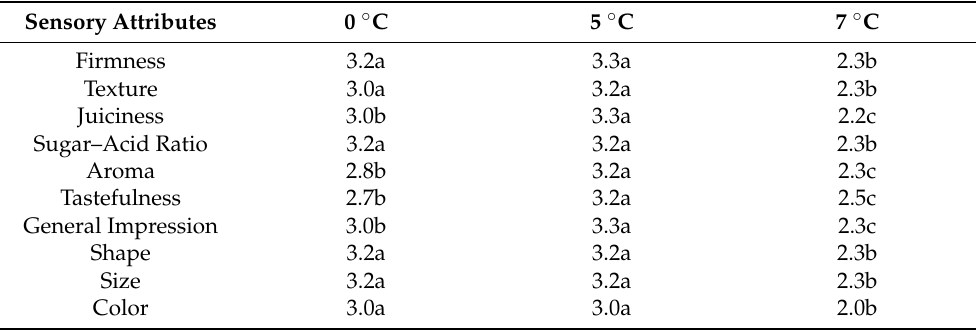
Table 2. Sensory evaluation of goji berries stored at three different temperatures for 9 days. A 1–5 anchored scale was used with 5 = excellent (fresh-like), 4 = very good, 3 = good (limit of marketability), 2 = acceptable (limit of edibility), and 1 = unsatisfying (not edible). In each line, values marked with the same letter are not significantly different according to a Tukey’s test ( p <